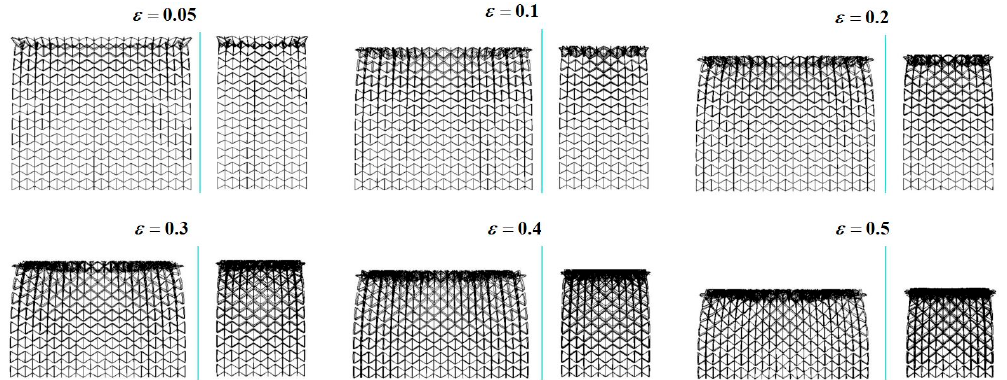
Figure 6. Deformation process of the 3D re-entrant auxetic structure under the crushing velocity 𝑣 (cid:3030) = 50 m/s. v c = 50